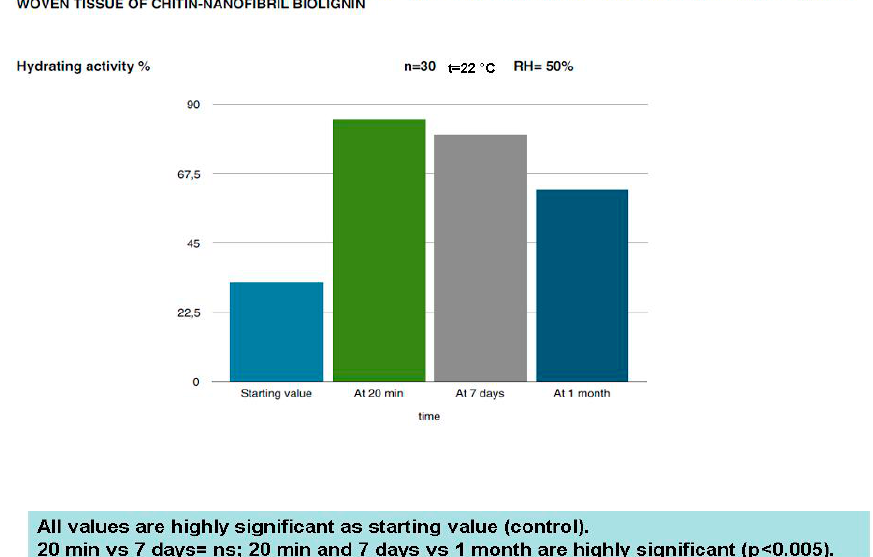
Cosmetics 2016 , 3 , 41 Figure 8. Moisturizing effectiveness of the in-study mask on the skin of photoaged women.